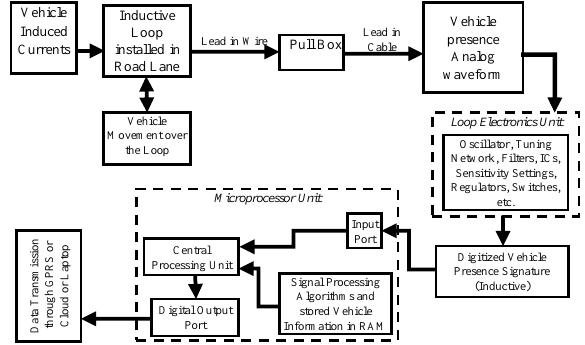
Figure 4. Architectural Diagram ILD Technology to capture, store and transmit the real time TD.